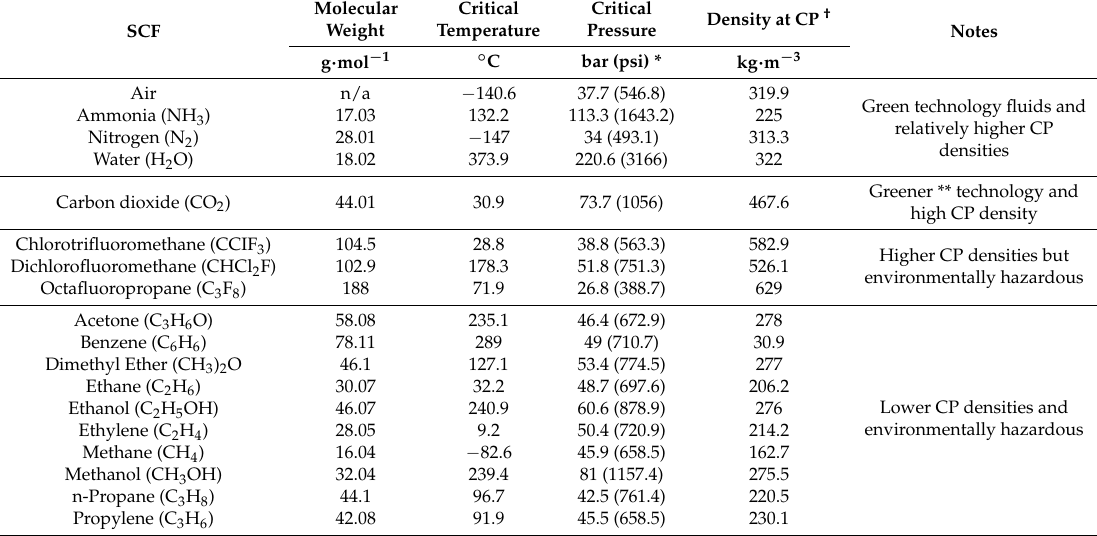
Table 3. Apparent physical properties for various supercritical fluids